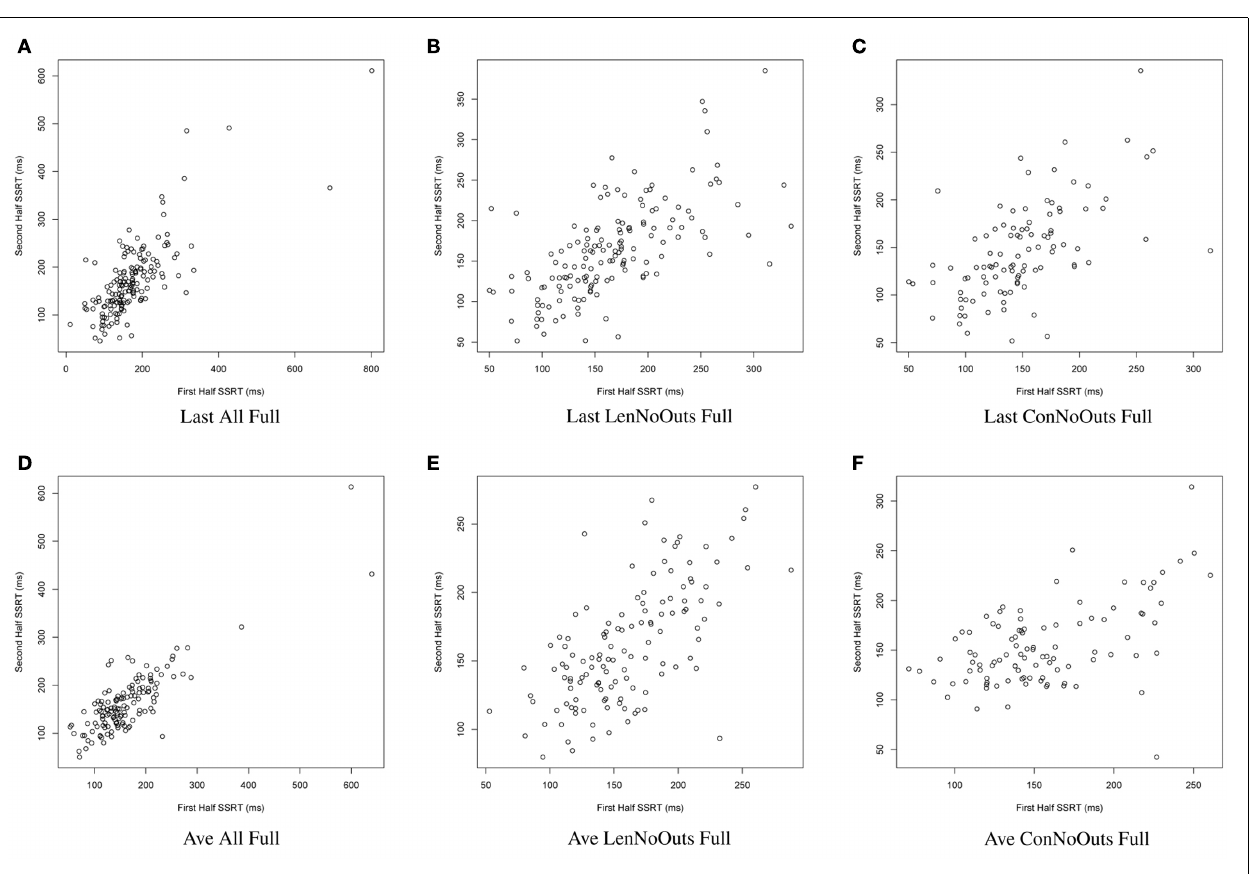
FIGURE 1 | SSRT calculation approaches (A–F): plots of SSRT calculated from two random halves of trials according to the first six approaches. SSRT values (in ms) from the first random half of data (x-axis) are plotted against SSRT values from the second random half (y-axis) from a single iteration.The top row includes the last run of all available runs, while the